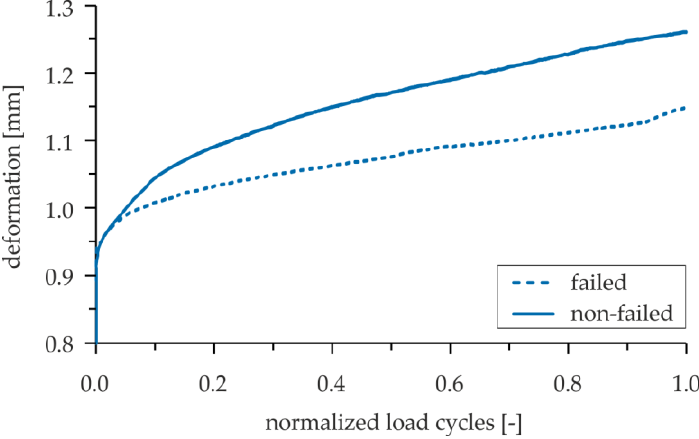
Figure 6. Comparison of cyclic creep curves of a failed and a non-failed specimen (here: anchorage length = 4 a ; σ min / σ max = 30%/95%).